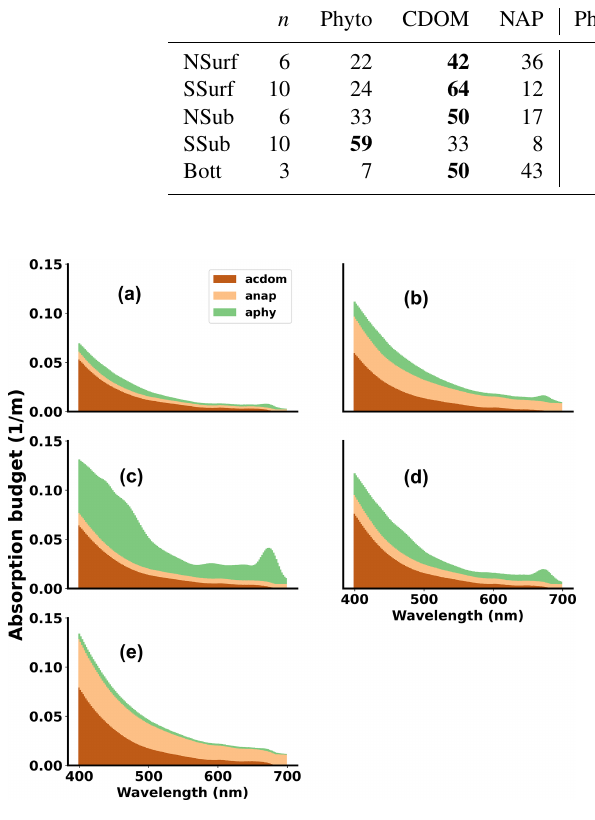
Figure 10. Absorption budget for five typical cases, correspond- ing to (a) northern surface (NSurf), (b) southern surface (SSurf), (c) northern subsurface (NSub), (d) southern subsurface (SSub), and (e) dense bottom water (Bott). Surface (subsurface) water is defined as < 15m (15–60m) water depth. The dense bottom water corresponds to the layer trapped by the sill at stations 505, 508, and 509.